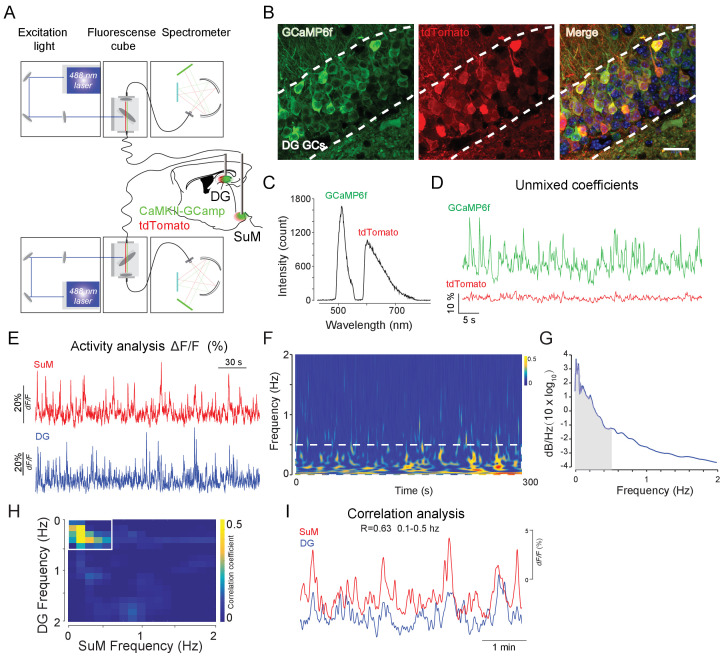
Experimental protocol of fiber photometry recording.(A) Schematic illustration of the photometry system used for measuring red and green fluorescent sensors in the SuM and DG. CaMKII-GCaMP6f and CAG-tdTomato were delivered to the left DG and SuM. (B) Co-expression of GCaMP6f and tdTomato in DG GCs. Scale bar = 20 µm. (C) Mixed emission spectrum of GCaMP6f and tdTomato. (D) Unmixing coefficients of GCaMP6f and tdTomato by fitting signals to standard emission curves. TdTomato signals were further used as motion correction during recording. (E) Sample traces of simultaneous recording from the SuM and DG post unmixing and normalized process. Those data were used for activity analysis. (F) The color code sample frequency of SuM and DG calcium signals were mainly appeared at 0.1–0.5 Hz. (G) The calcium signals > 0.5 Hz were lower than 0.01 dB/Hz. Due to the low calcium signal associated with >0.5 Hz, we selected 0.1–0.5 Hz frequency range to analyze correlation of calcium activities from the SuM and DG. (H) Heatmap of the correlation coefficient in SuM and DG GCaMP frequency spectrum. (I) Correlation of SuM and DG GCaMP signals in 0.1–0.5 Hz range during home cage recording.